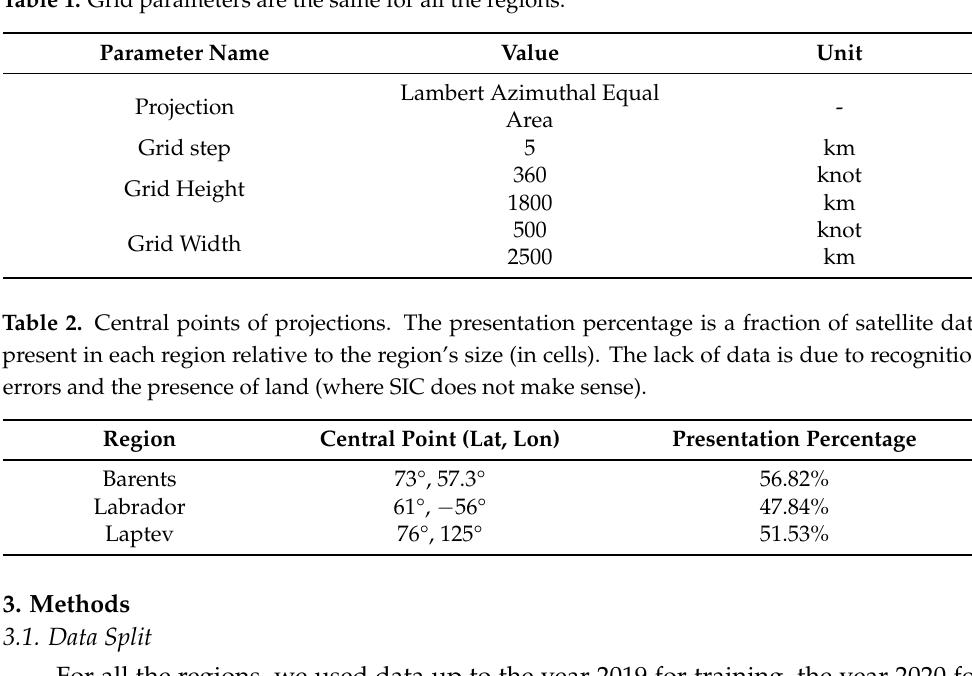
Figure 3. Regions definitions. ( a ) Arctic with colored boxes indicating the three regions: ( b ) the Barents and Kara Seas, ( c ) the Labrador Sea, and ( d ) the Laptev Sea. In Barents and Labrador regions, sea ice concentration is depicted for 1 April 2021, and in the Laptev region for 1 October 2021, since on 1 April 2021 the region is almost frozen. The area between the green (15%) and red (80%) isolines is the marginal ice zone for these dates. Table 1. Grid parameters are the same for all the regions.